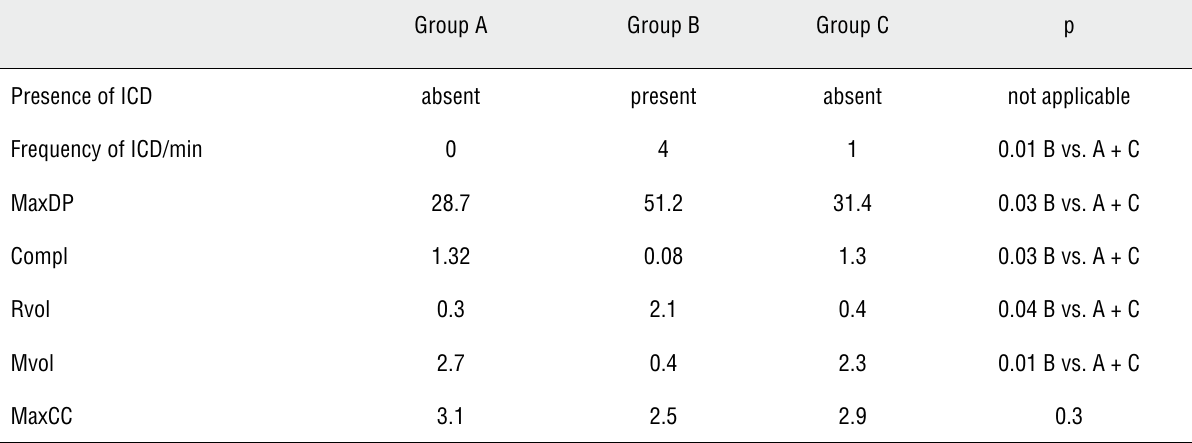
Table 1 - Findings from the urodynamic evaluation performed four weeks after the sham procedure (group A), partial obstruc- tion of the bladder neck using a silver ring (group B) and chronic obstruction together with the use of the flavonoid galangin (group c). The data are expressed as means.